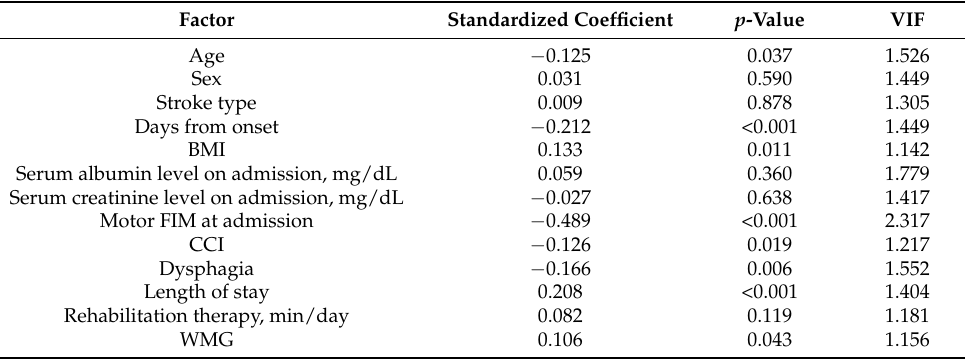
Table 2. Multivariate analysis of motor FIM gain (model 1).